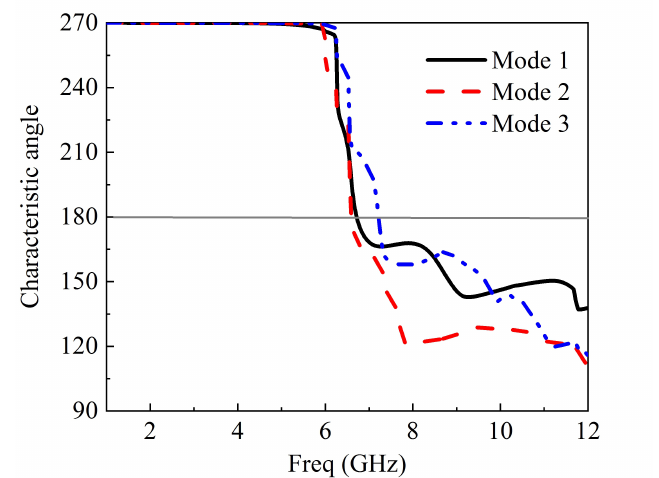
Figure 16. Characteristic angle for three modes at 7